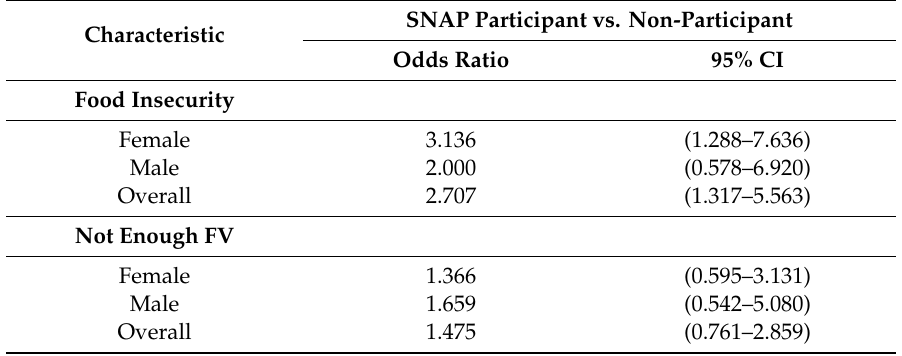
Table 4. Odds of Food Insecurity and Not Consuming Enough FV by SNAP